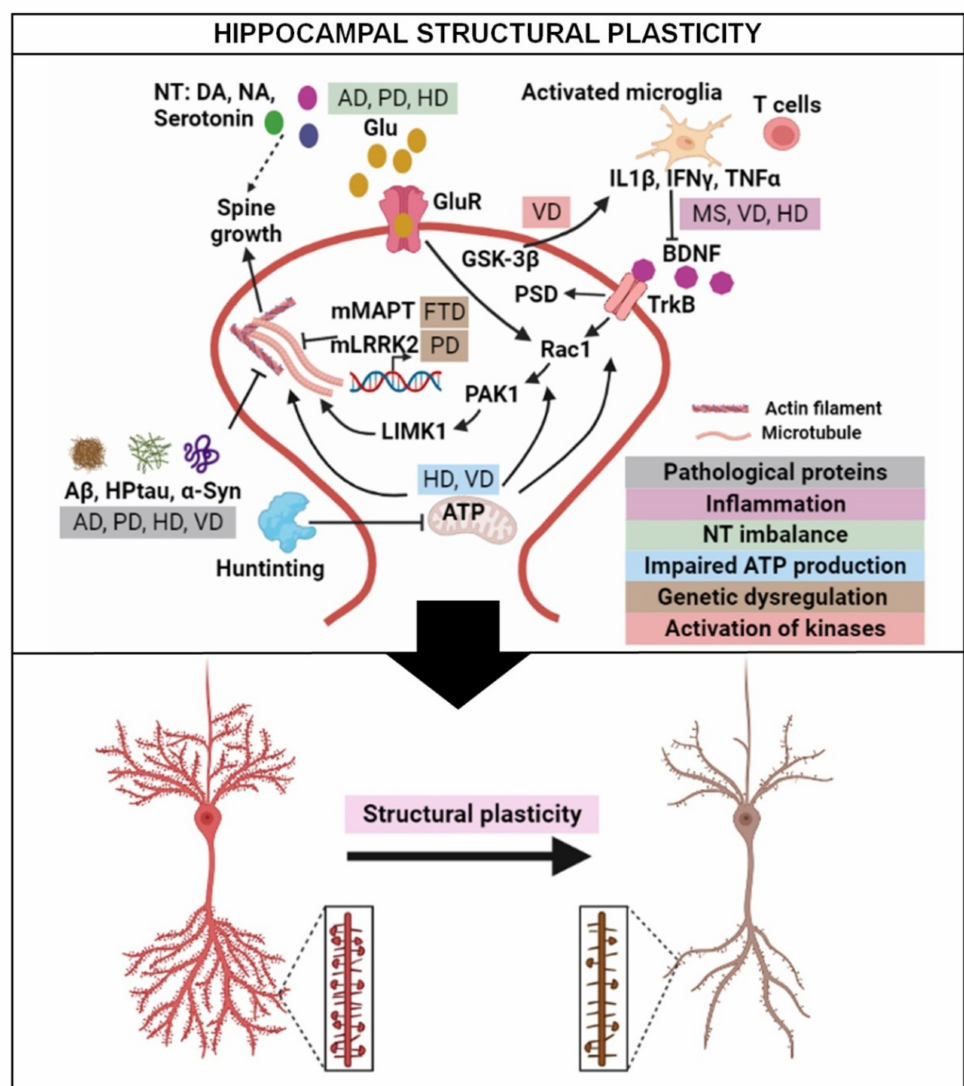
Figure 2. Schematic illustration of proposed mechanistic pathways for alteration of structural plastic- ity in the hippocampus in neurodegenerative diseases. During neurodegenerative diseases, patholog- ical proteins, inflammation, neurotransmitter imbalance, impaired energy production, genetic factors, and activation of kinases affect the actin cytoskeleton and/or microtubule arrangement through different pathways. Abbreviations: AD, Alzheimer’s disease; α -Syn, alpha-synuclein; A β , amyloid- β ; ATP, Adenosine 5 (cid:48) -triphosphate; BDNF, brain-derived neurotrophic factor; DA, dopamine; FTD, frontotemporal dementia; Glu, glutamate; GluR, glutamate receptor; GSK-3 β , glycogen synthase kinase3 β ; HD, Huntington’s disease; IFN γ , interferon γ ; IL-1 β , interleukin 1 β ; LRRK2, leucine-rich repeat kinase 2; LIMK1, LIM kinase 1; MAPT, microtubule-associated tau; MS, multiple sclerosis; NA, noradrenaline; NT, neurotransmitter; PAK1, P21 (RAC1) Activated Kinase 1; PD, Parkinson’s disease; PSD, post-synaptic density; HPtau, hyperphosphorylated Tau; Rac1, Ras-related C3 botulinum toxin substrate 1; TNF α , tumor necrosis factor α ; TrkB, tyrosine receptor kinase B; VD, vascular